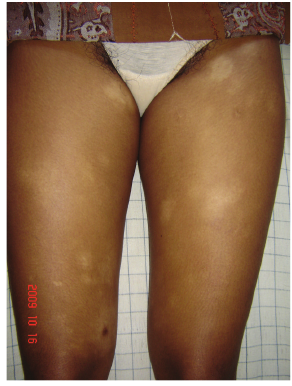
Figure 5: A 29-year-old woman showing hypopigmented skin patches on thigh after 32 sessions of narrow band-UVB therapy (patient 5).